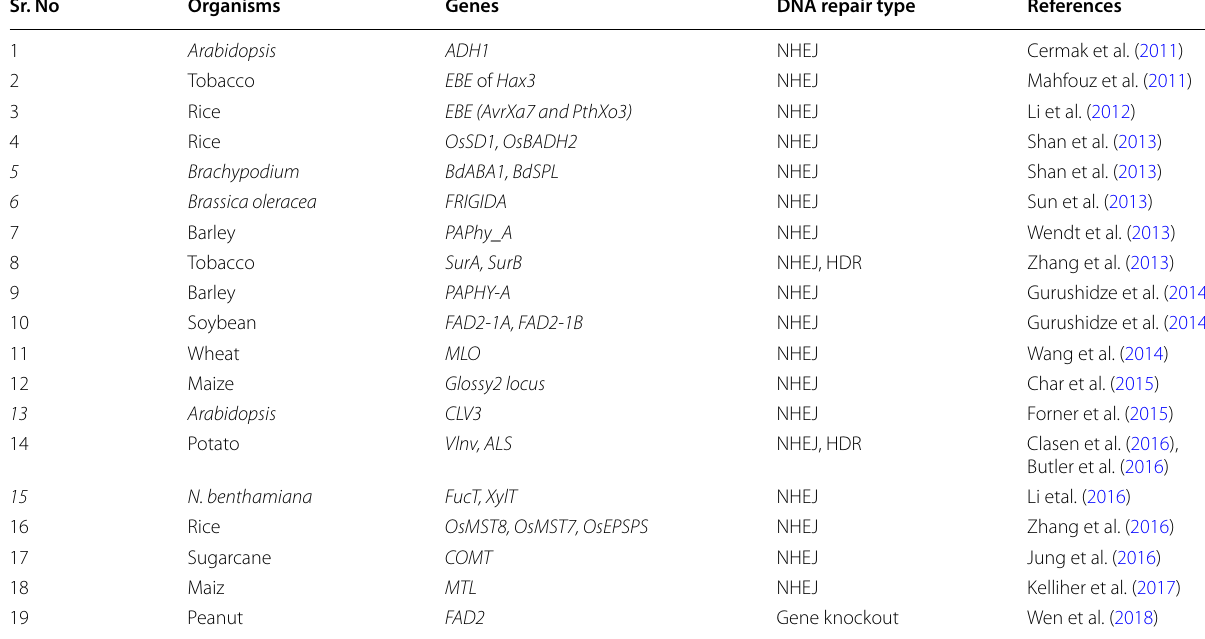
Table 4 TALEN-mediated genome editing in plants Sr.